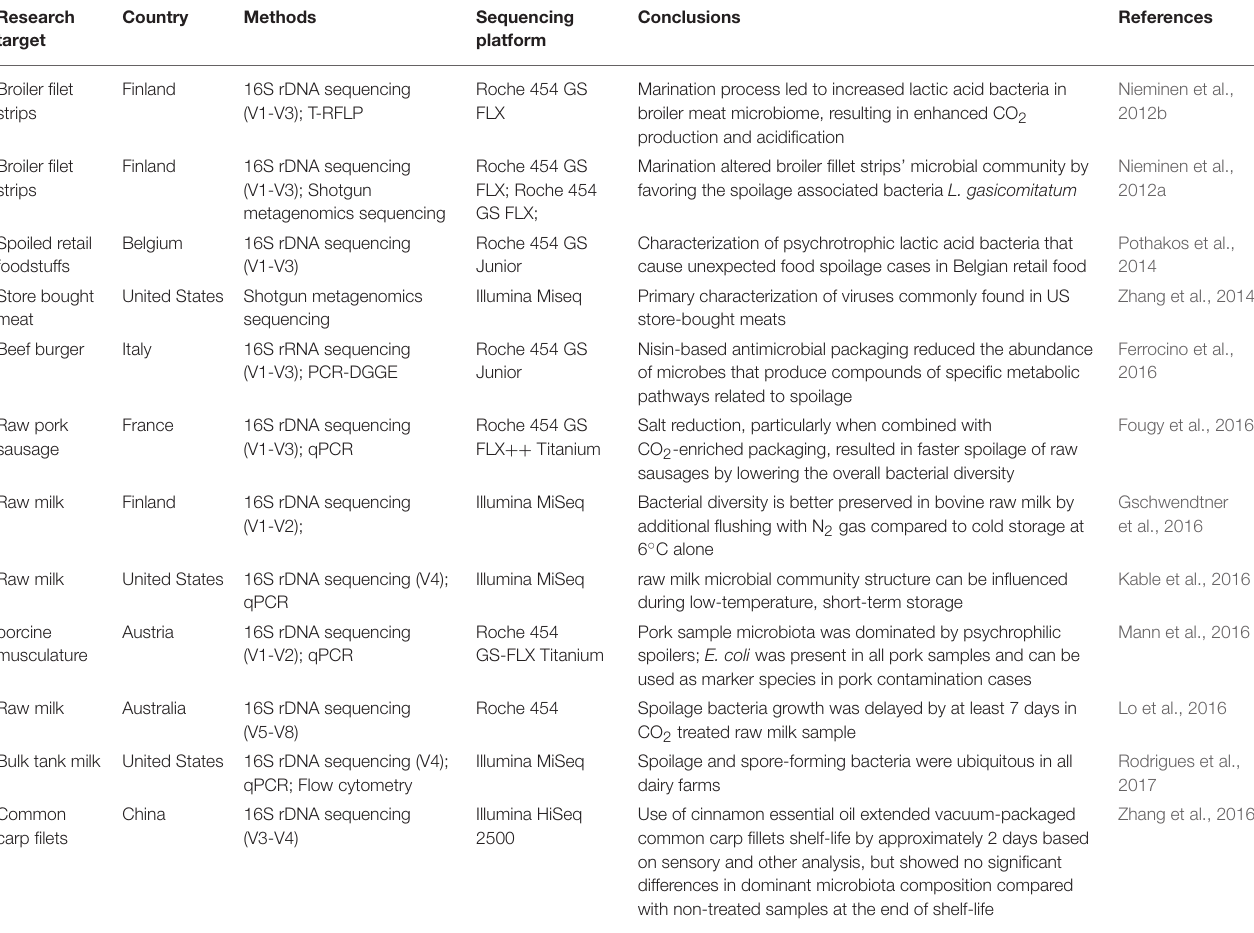
TABLE 2 | A comprehensive list of publications using next generations sequencing approaches used in characterizing the microbiome of raw food